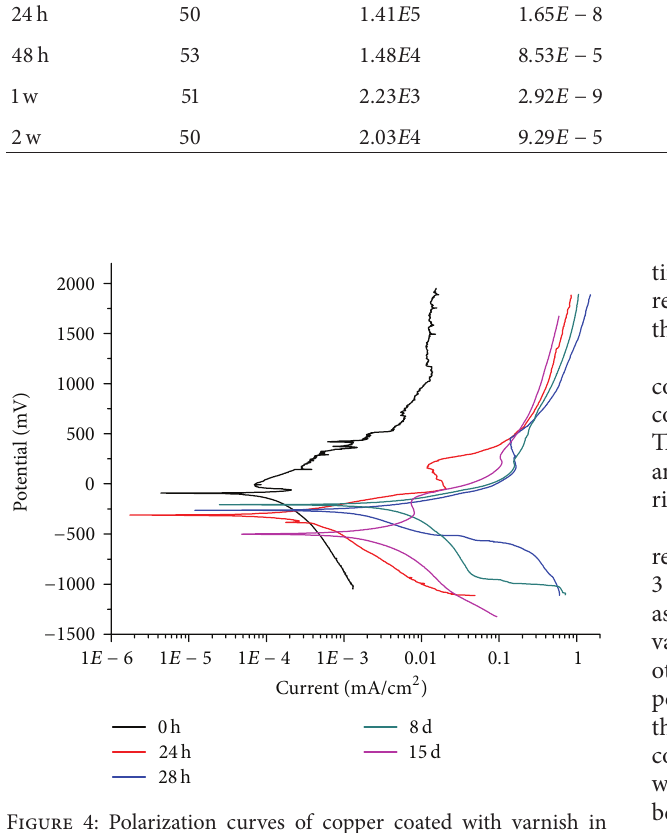
Figure 4: Polarization curves of copper coated with varnish in Na 2 SO 4 + NaCl solution, as a function of